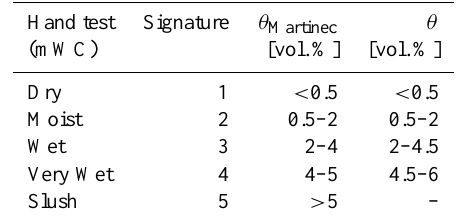
Table 5. Proposition of interpretation of manually estimated